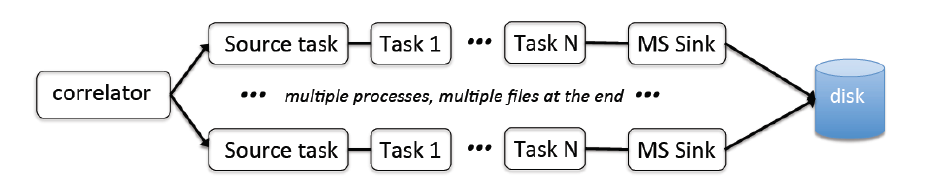
Figure 1. Ingest pipeline can be viewed as a series of pre-defined tasks executed sequentially for each independent data chunk received and written in